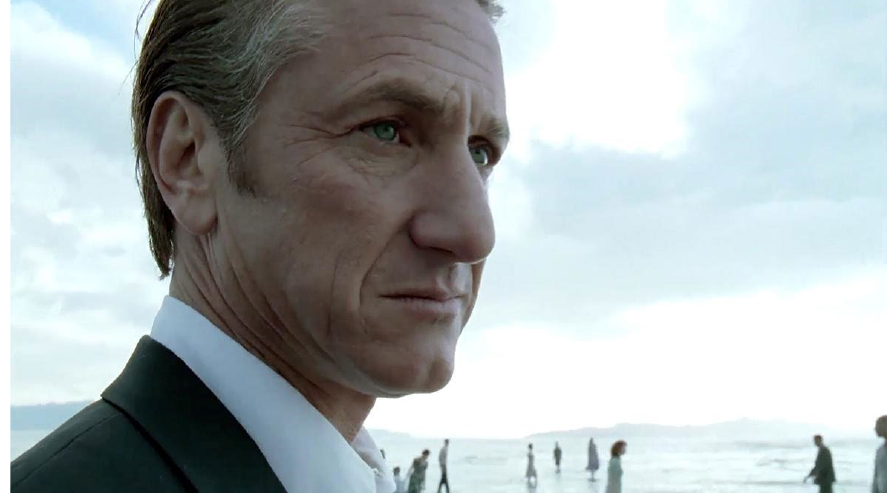
Figure 17 Architect, Jack O'Brien in The Tree of Life.